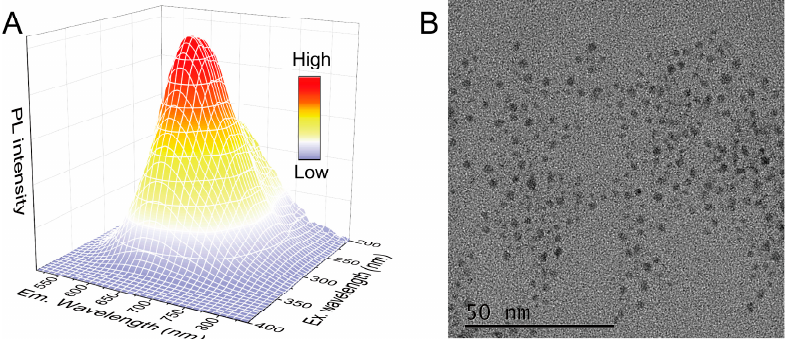
Figure 1. ( A ) Three-dimensional PL spectra of the prepared CC/DTT-AuNCs. ( B ) TEM image of